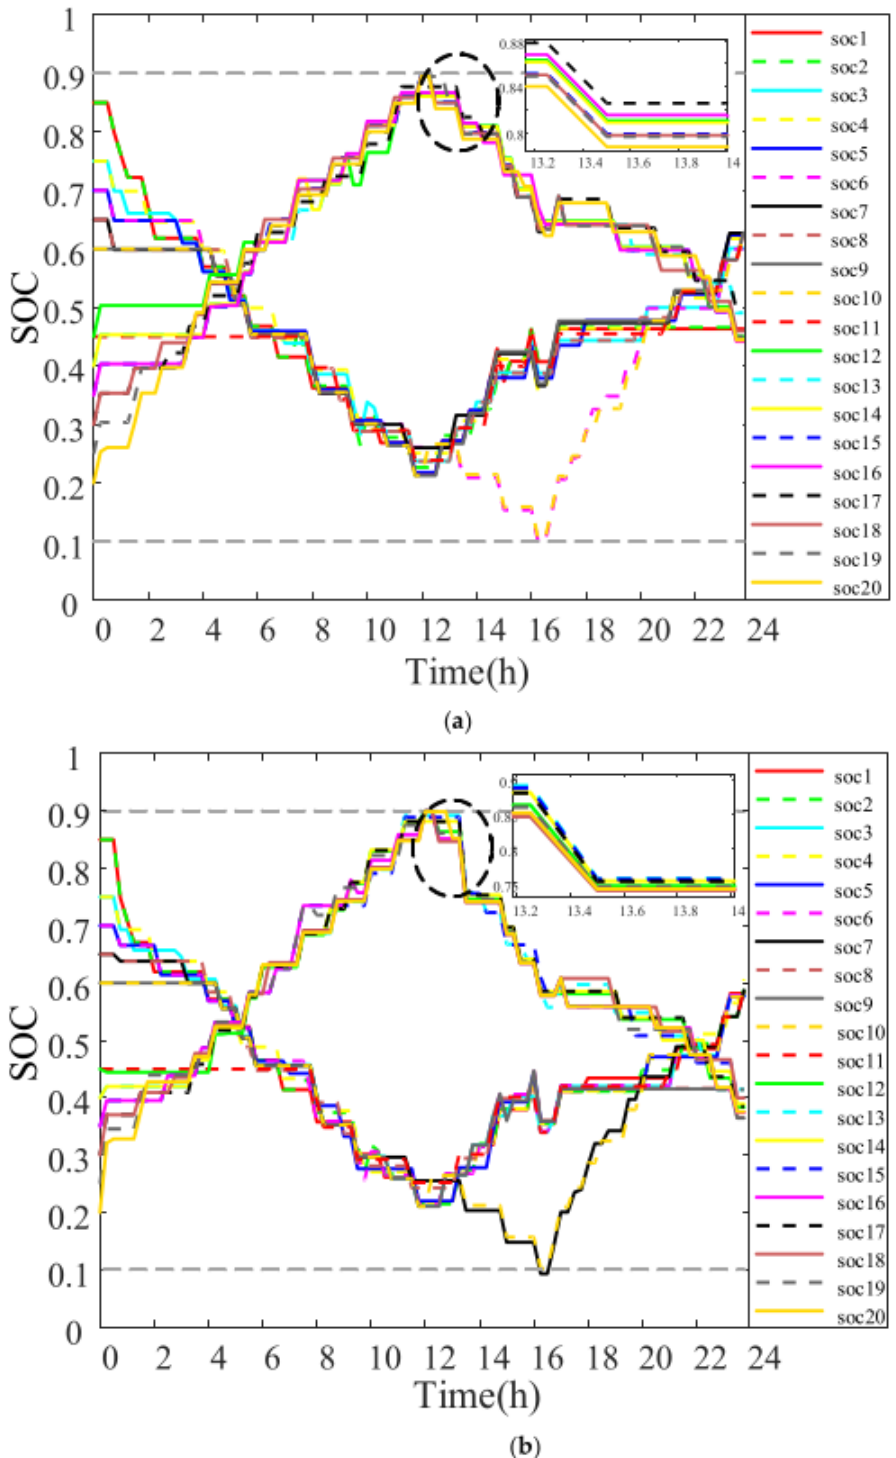
Figure 8. SOC variation curve of each energy storage unit. ( a ) Average power distribution; ( b ) Multi-agent SOC